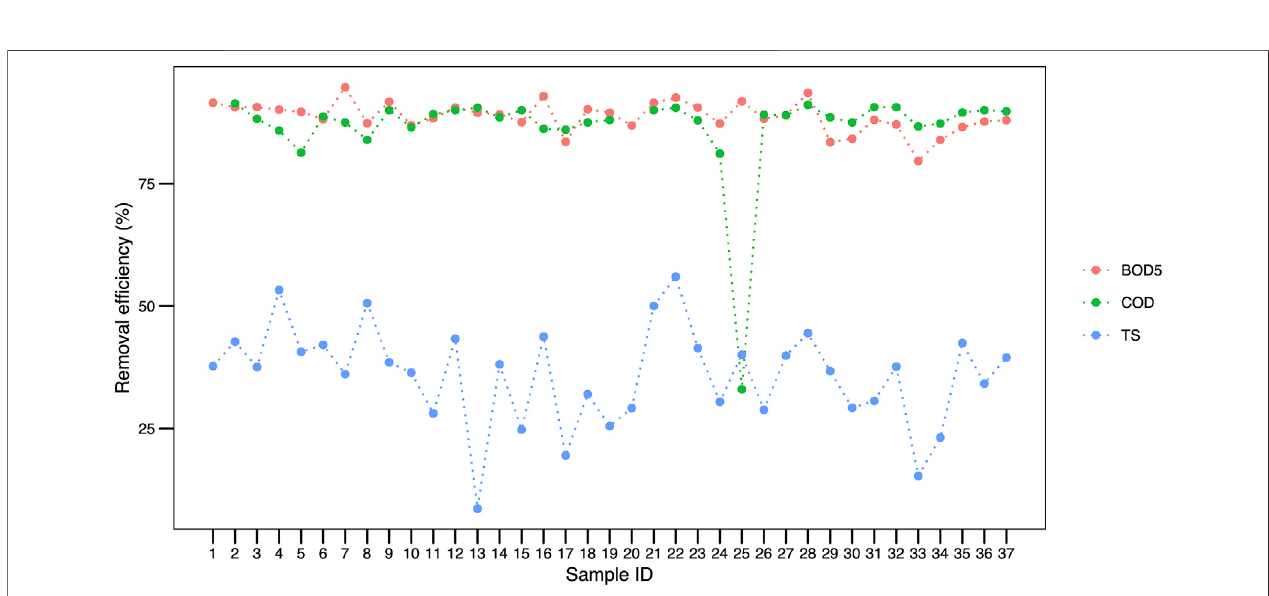
FIGURE 7 | BOD 5 , COD and TS removal ef fi ciency recorded throughout 37 samplings in a wastewater treatment plant in Brazil. Legend: BOD5, biochemical oxygen demand; COD, chemical oxygen demand; TS, total solids.